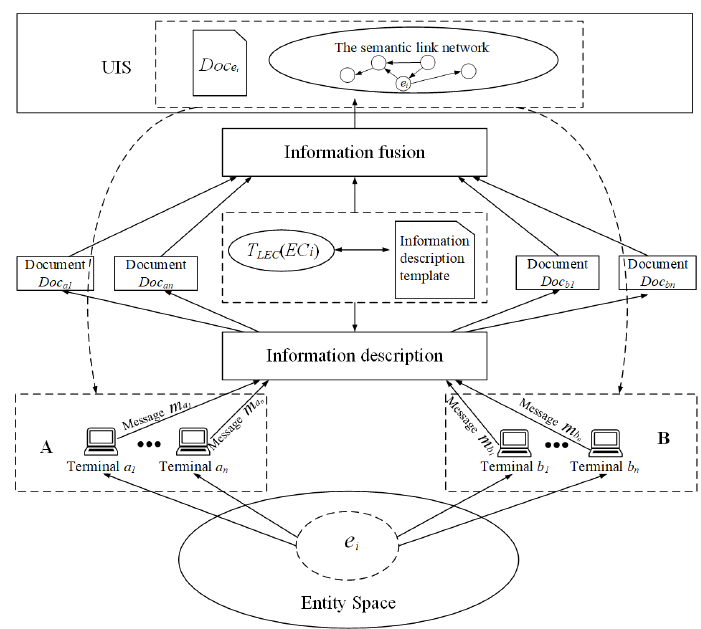
Figure 10. Implementation progress of information sharing.